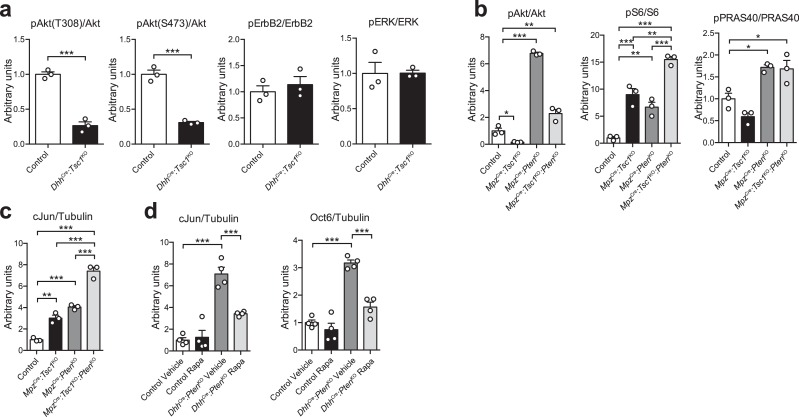
Quantification of western blots.Bar height: mean; error bars: s.e.m. (a) Quantification referring to Figure 2a. Control average is set to 1 (n = 3 mice/genotype, including the biological replicates representatively shown in Figure 2a, two-tailed unpaired Student’s t-test; pAkt(T308)/Akt, t(4) = 11.43, p=0.0003; pAkt(S473)/Akt, t(4) = 11.19, p=0.0004; pErbB2/ErbB2, t(4) = 0.7119, p=0.5158; pERK/ERK, t(4) = 0.02554, p=0.9808). (b) Quantification referring to Figure 2c. Control average is set to 1 (n = 3 mice/genotype, including the biological replicates representatively shown in Figure 2c; pAkt/Akt, one-way ANOVA with Dunnett’s multiple comparisons test, F(3,8) = 251.6, p<0.0001, pcontrol vs TSC1KO = 0.0313, pcontrol vs PTENKO = 0.0001, pcontrol vs doubleKO = 0.0030; pS6/S6, one-way ANOVA with Tukey’s multiple comparisons test, F(3,8) = 58.58, p<0.0001, pcontrol vs TSC1KO = 0.0004, pcontrol vs PTENKO = 0.0040, pcontrol vs doubleKO <0.0001, pTSC1KO vs doubleKO = 0.0017, pPTENKO vs doubleKO = 0.0002; pPRAS40/PRAS40, one-way ANOVA with Dunnett’s multiple comparisons test, F(3,8) = 18.5, p=0.0006, pcontrol vs PTENKO = 0.0103, pcontrol vs doubleKO = 0.0134). (c) Quantification referring to Figure 2g. Control average is set to 1 (n = 3 mice/genotype, including the biological replicates representatively shown in Figure 2g, one-way ANOVA with Tukey’s multiple comparisons test, F(3,8) = 123.4, p<0.0001; pcontrol vs TSC1KO = 0.0016, pcontrol vs PTENKO <0.0001, pcontrol vs doubleKO <0.0001, pTSC1KO vs doubleKO <0.0001, pPTENKO vs doubleKO <0.0001). (d) Quantification referring to Figure 2k. Vehicle-treated control average is set to 1 (n = 4 mice/condition, including the biological replicates representatively shown in Figure 2k, one-way ANOVA with Tukey’s multiple comparisons test; cJun/Tubulin, F(3,12) = 37.14, p<0.0001, pvehicle control vs PTENKO <0.0001, pPTENKO vehicle vs rapamycin = 0.0006; Oct6/Tubulin, F(3,12) = 45.07, p<0.0001, pvehicle control vs PTENKO <0.0001, pPTENKO vehicle vs rapamycin <0.0001). *p<0.05, **p<0.01, ***p<0.001.